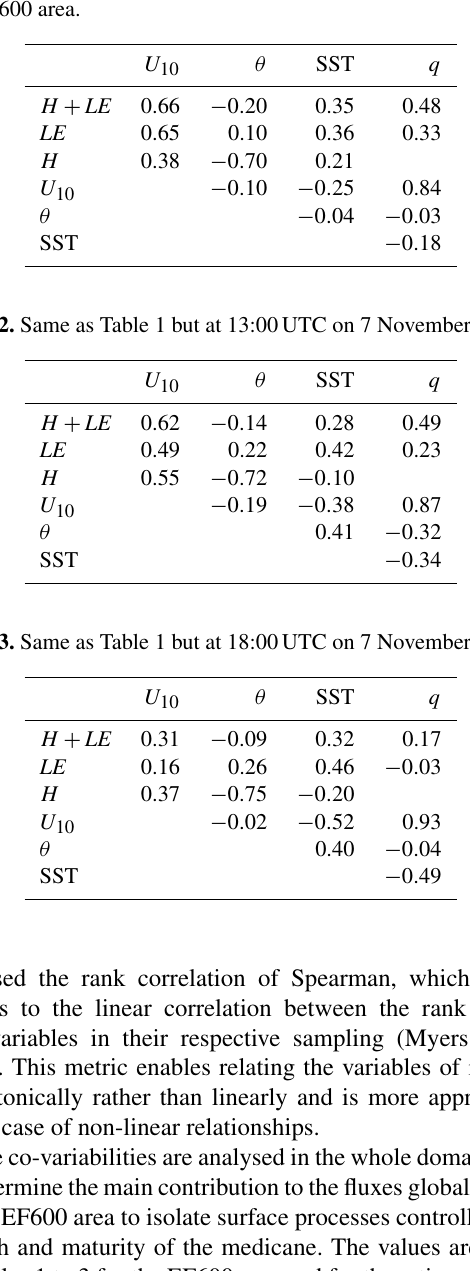
Table 1. Spearman’s rank correlations between the enthalpy flux, latent and sensible heat flux, and related parameters (10m wind speed U 10 , potential temperature at 10m θ, SST and humidity at 10m q) at 09:00UTC on 7 November, from the CPL simulation, in